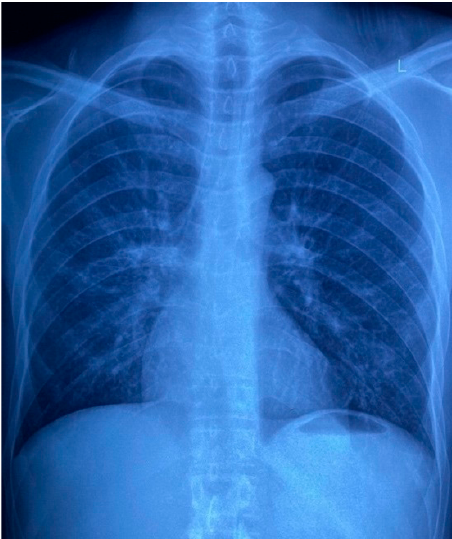
Figure 7. Patient’s chest x-ray on admission, demonstrating a nodular infiltrate in the lower lobe and lingula of the left lung.